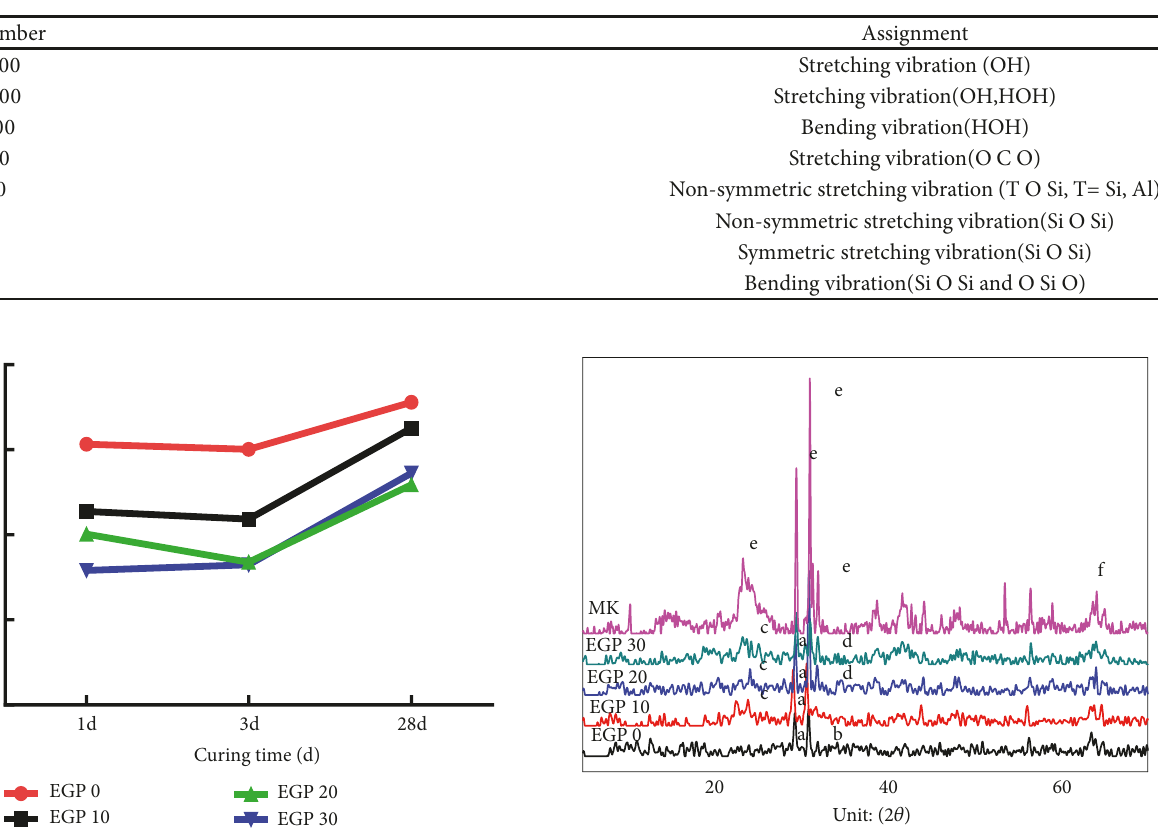
Table 3: Infrared vibration peaks of metakaolin and geopolymer.